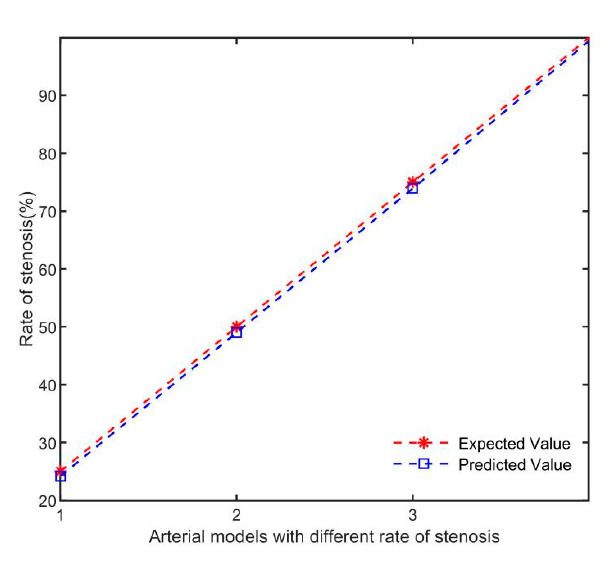
Figure 14. Prediction results of rates of stenosis in different arterial models.